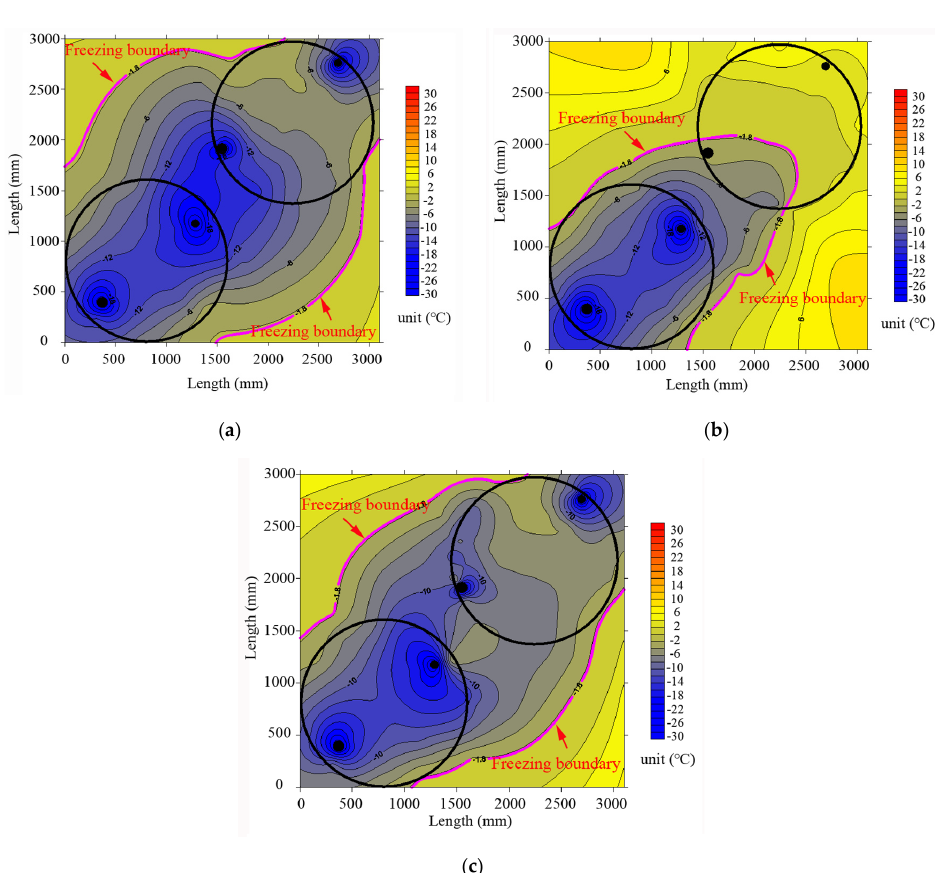
Figure 12. Cloud chart of temperature field of active freeze period after 60 days’ freeze: ( a ) Cloud chart of synergy freezing of the solid pipe and hollow pipe; ( b ) Cloud chart of single freezing of the solid pipe; ( c ) Cloud chart of principal freezing of the solid pipe with hollow pipe as